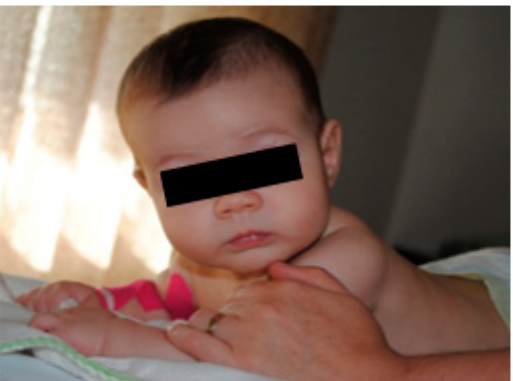
Figure 6. Prone position.